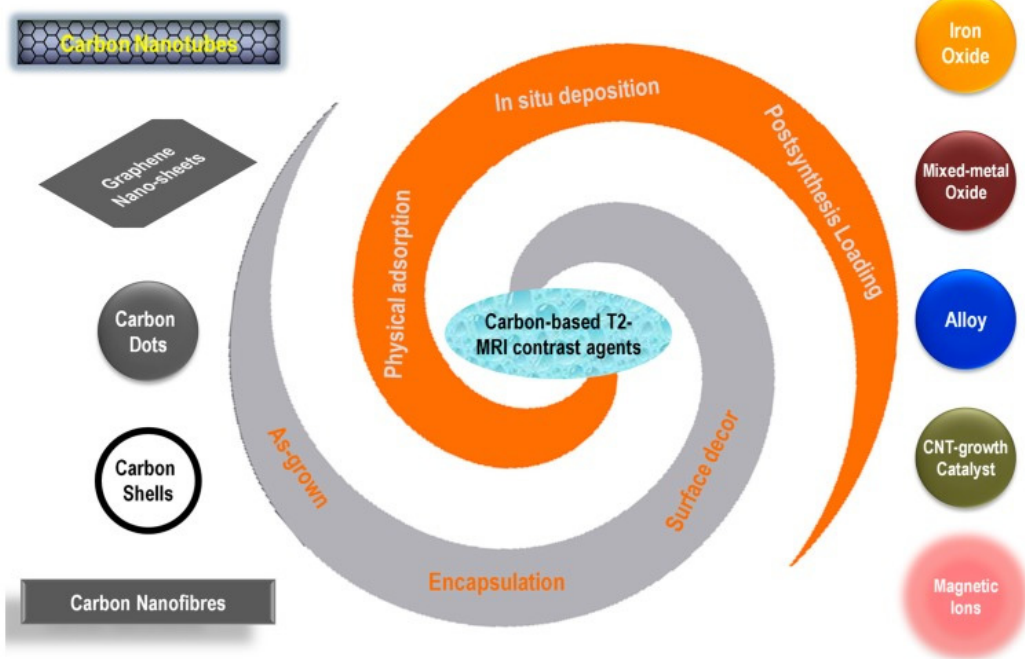
Figure 2. Schematic illustration of various carbon nanoallotropes, magnetic species and their conjugation strategies used for the preparation of T2-weighted MRI contrast agents [27] .